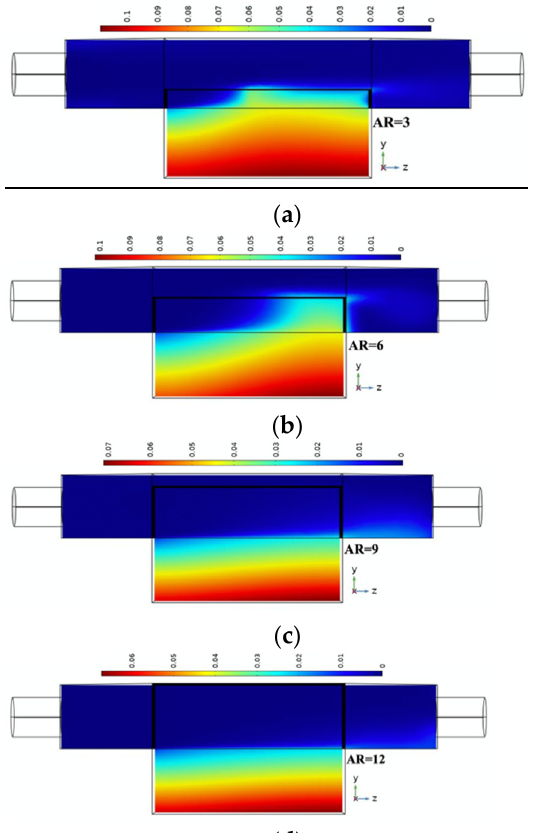
Figure 7. Temperature distribution at the middle of the test section ( a – d ) and near the wall ( e – h ).